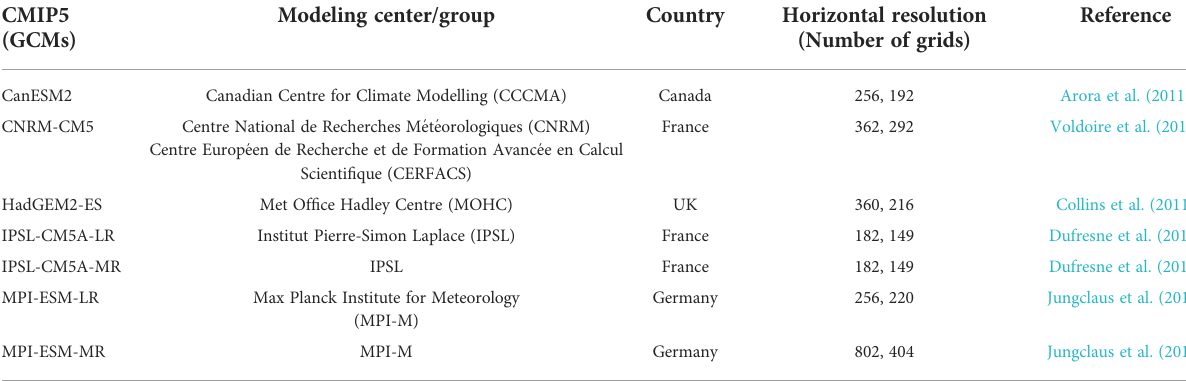
TABLE 2 List of the Coupled Model Intercomparison Project Phase 5 (CMIP5) models for the projection of the anchovy ( Engraulis japonicus ) habitat in Korean waters.